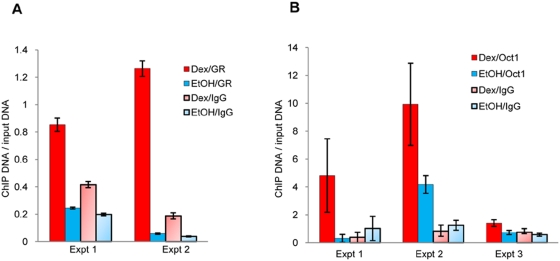
Glucocorticoid-dependent GR and Oct1 occupancy of the region containing rs9493857.(A) GR binds the region containing rs9493857 following dexamethasone (10−6 M) treatment in MCF10A-Myc cells. Each measurement is the average of three Q-RT-PCR technical replicates normalized by the input DNA. The error bars represent the standard error. The results of two independent biological replicates are plotted. (B) Oct1 binds the region containing rs9493857 following dexamethasone (10−6 M) treatment in MCF10A-Myc cells. Each measurement is the average of three Q-RT-PCR technical replicates normalized by the input DNA. The error bars represent the standard error. The results of three independent biological replicates are plotted.